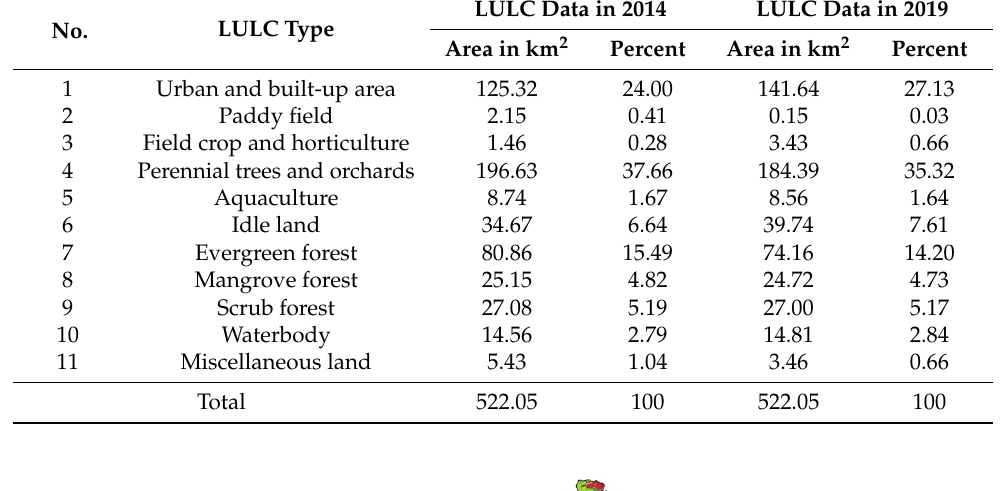
Table 7. Area and percentage of LULC data in 2014 and 2019.